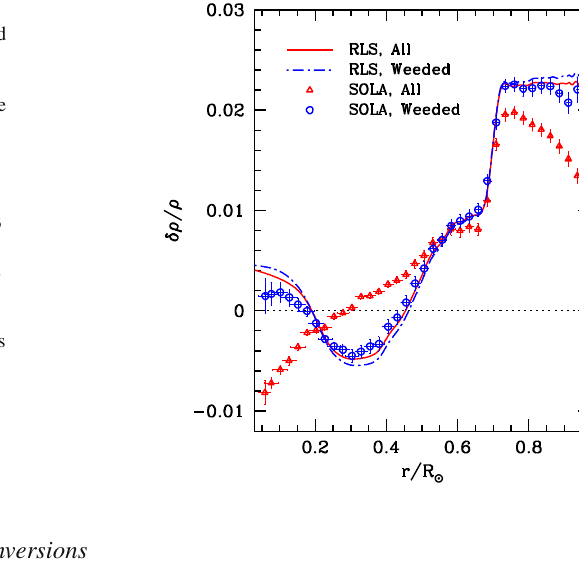
Fig. 14 Relative density differences between the Sun and model BP04 of Bahcall et al. (2005a) obtained using both RLS and SOLA techniques. The results marked ‘All’ were obtained using the modeset GOLF1low (see text) while the results marked ‘Weeded’ where obtained when the (cid:2) = 0 , n = 3 and (cid:2) = 3 , n = 5 modes were removed from the set. Note that RLS results remain the same, but SOLA results change drastically. The inversion results are from Basu et al.